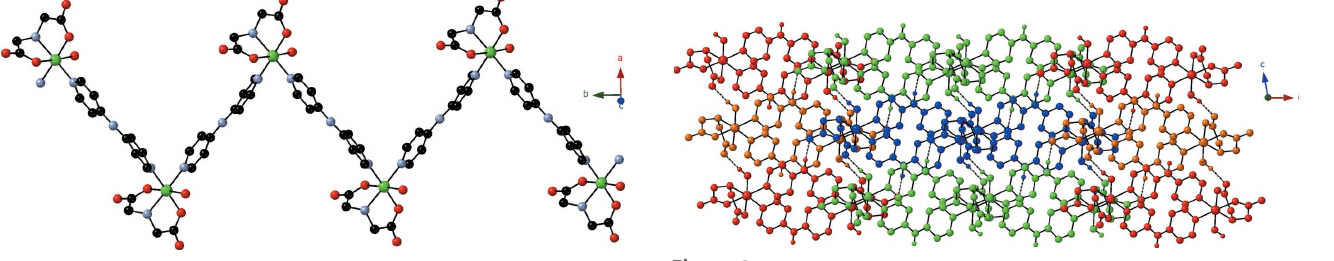
Figure 3 Interaction of the [Ni(ima)(dpa)(H 2 O)] n coordination polymer chain motifs by O—H (cid:2)(cid:2)(cid:2) O and N—H (cid:2)(cid:2)(cid:2) O hydrogen bonds, which are shown as dashed lines. Individual ribbon motifs are colored for clarity.